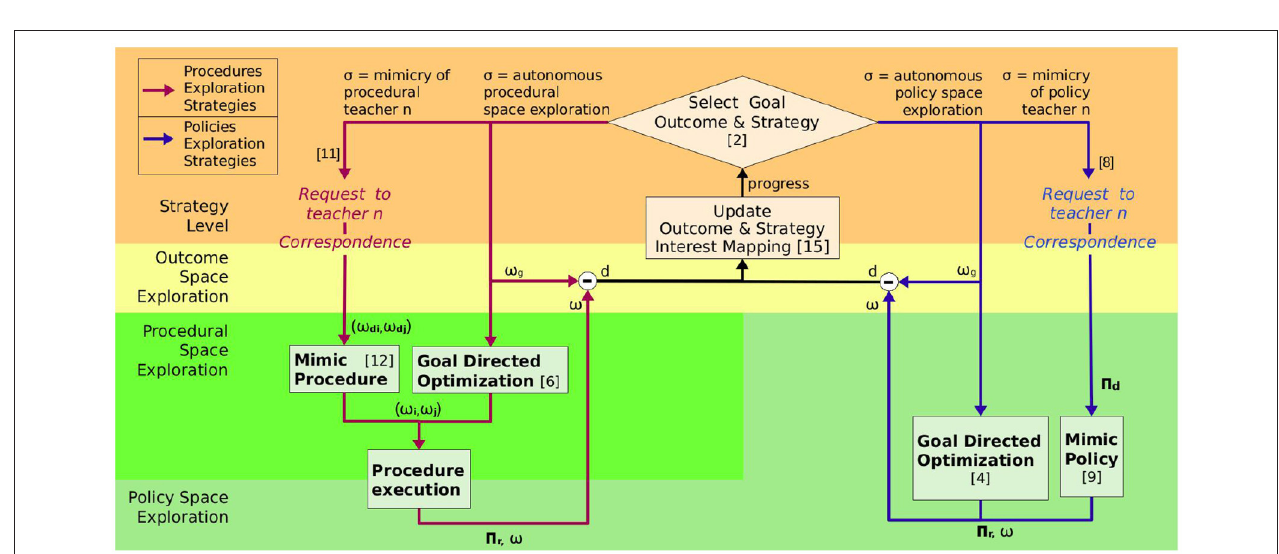
FIGURE 2 | SGIM-PB architecture: number between brackets link parts of the architecture with corresponding lines in Algorithm 2 , the arrows show the data transfer between the different blocks.